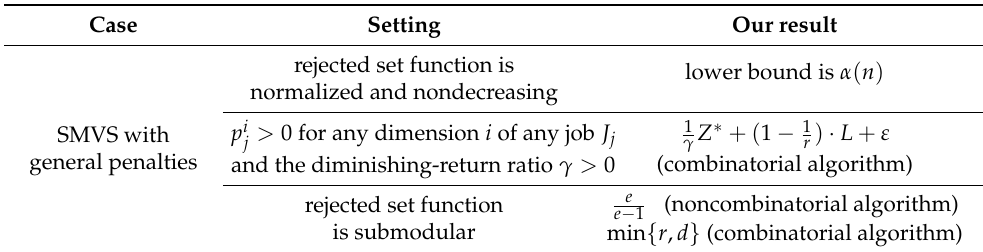
Table 1. The results in this